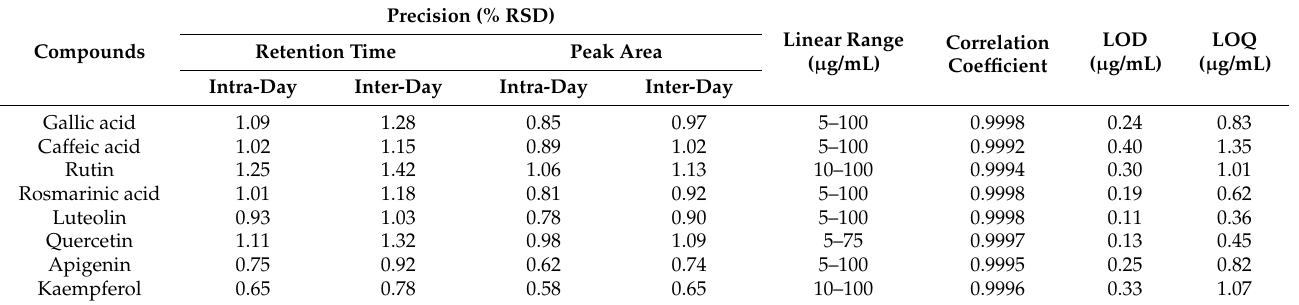
Figure 1. HPLC chromatograms of mixed standard, sample TL − C − 60E, and sample TL − C − 80E with the detection wavelength at 325 nm. The peaks indicate (a) gallic acid, (b) caffeic acid, (c) rutin, (d) rosmarinic acid, (e) luteolin, (f) quercetin, (g) apigenin, and (h) kaempferol. Table 1. Performance characteristics evaluated during method validation.